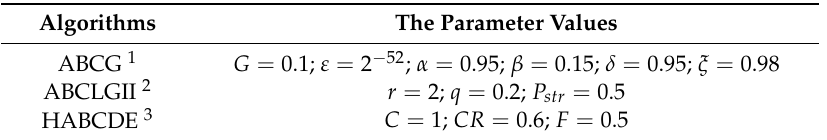
Table 2. Optimization parameters